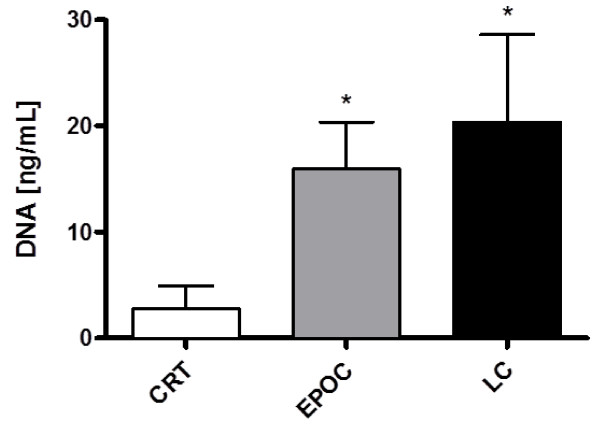
Representative analysis DNA of concentration from sputum samples from CTR, COPD and LC subjects. DNA concentration in samples of induced sputum obtained from COPD, LC and CTR subjects. Columns show the median and range values for each data group. * P < 0.0001 respect to control group (CTR), ** p >0,05 respect to COPD group.